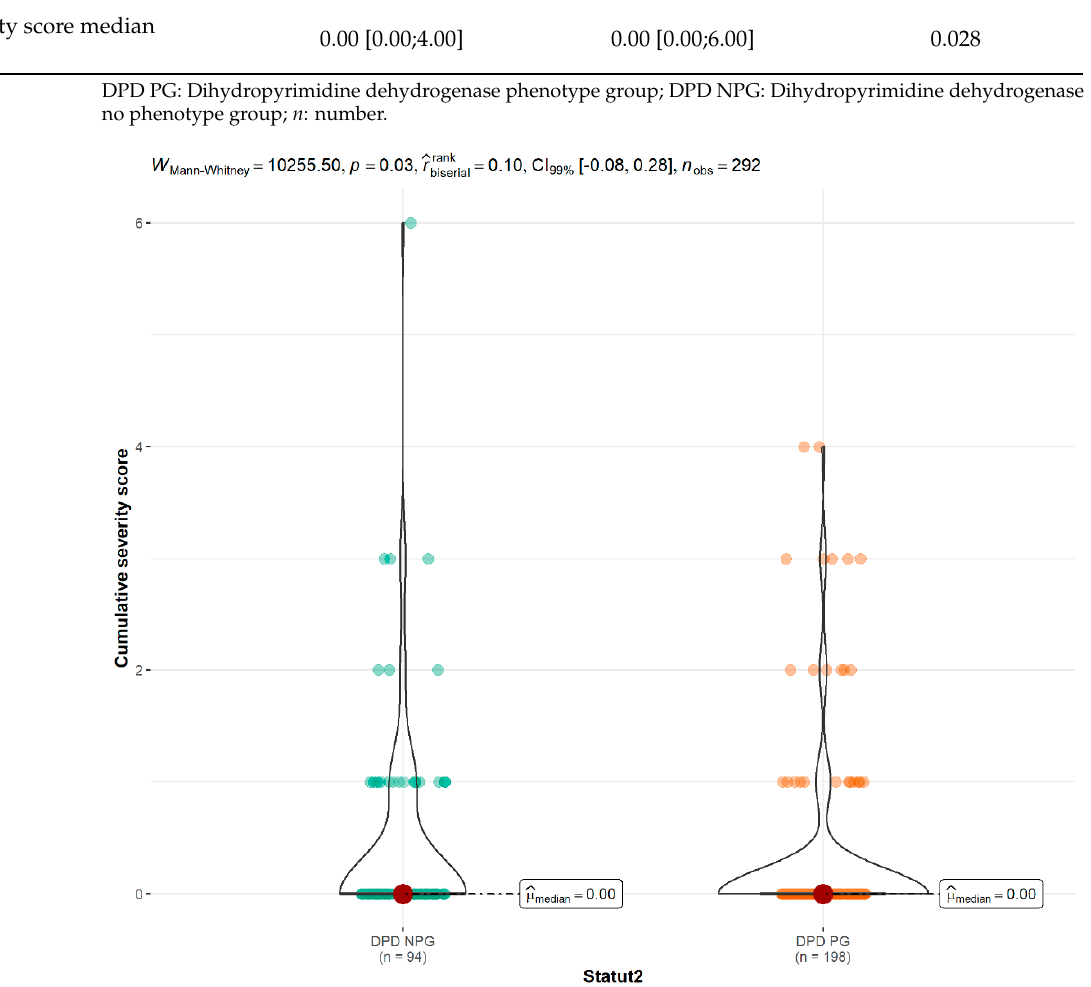
Table 3. Acute severe toxicities encountered (NCI grading). DPD PG ( n = 198)